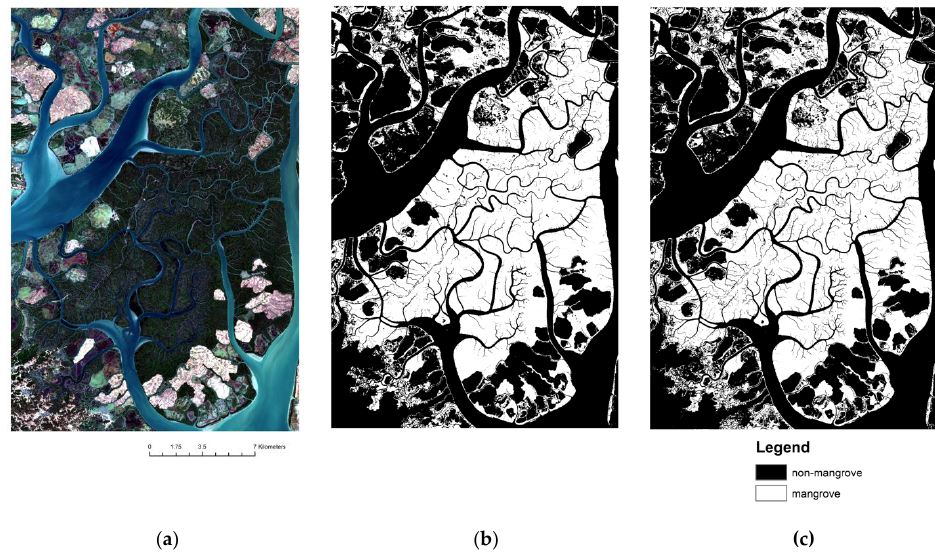
Figure 7. ( a ) Sentinel-2 true color image, ( b ) ground truthed image, and ( c ) classified image of Experiment 6 of the whole study area. Table 3. Experimental results of input feature adjustment.